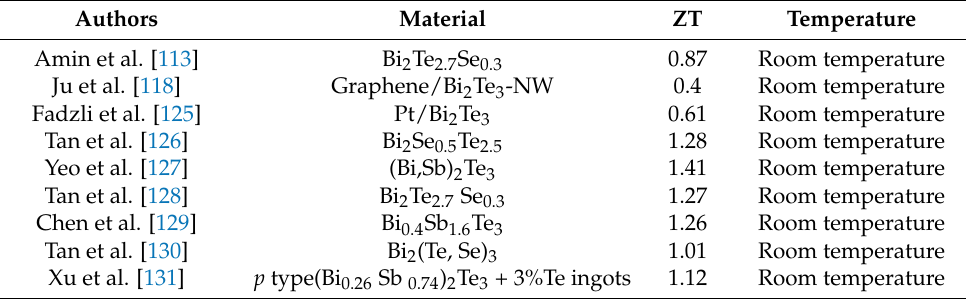
Table 5. The ZT values of Bi–Te-based materials.